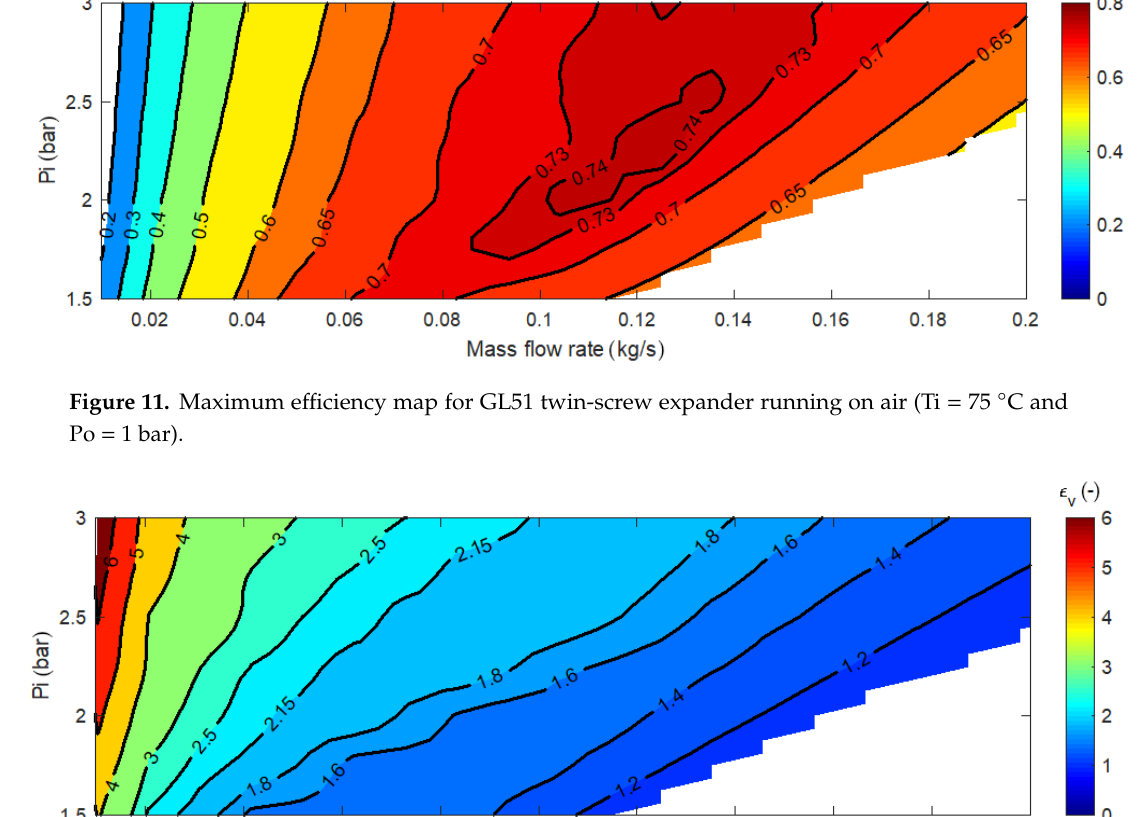
Figure 13. Rotational speeds corresponding to maximum isentropic efficiency of GL51 twin-screw expander running on air (Ti = 75 °C and Po = 1 bar). Based on the results (Figure 11), a better efficiency operation is achieved with increasing mass flow rates up to 0.07 kg/s for all investigated inlet pressures. The global optimum efficiency is achieved at mass flow rates between 0.100–0.140 kg/s with inlet pressures of 2.1–2.6 bar, respectively. This range of operation with maximum efficiency is achieved with a close to constant volume ratio of (cid:2035) (cid:3049) = 1.6 (Figure 12) for rotational speeds above 15,500 RPM (Figure 13). Larger mass flow rates beyond 0.14 kg/s show reductions in maximum efficiency. The losses during filling mean that the pressure at the start of expansion is relatively low, which effectively reduces the work done (area of the pV diagram), resulting in less mass per cycle and less work per cycle. The pressure drop across the inlet port means that there is lost work, and so, specific work tends to decrease at higher speeds. For the conditions above 15,000 RPM, the experimented machine configuration with (cid:2035) (cid:3049) 1.47 was found to be operating close to the best conditions suggested by the maximum efficiency maps. At the experimented condition with inlet pressure of 2 bar and mass flow rate of 0.102 kg/s, the experimentally established isentropic efficiency was found to be 0.7, while the optimum operation recommended by the efficiency map (Figure 11) for 2 bar inlet pressure with 0.102 kg/s is with (cid:2035) (cid:3049) = 1.49, where the machine achieves an isentropic efficiency of 0.74.